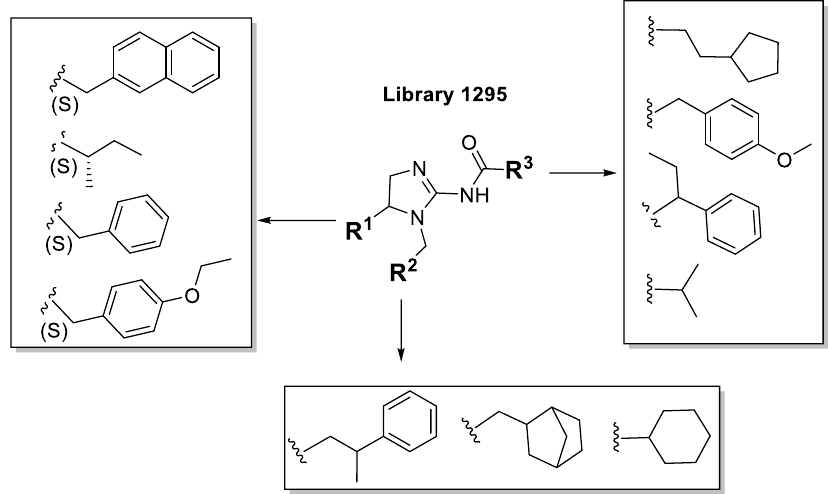
Figure 5 . Selected combinations of active mixtures with defined R 1 , R 2 , and R 3